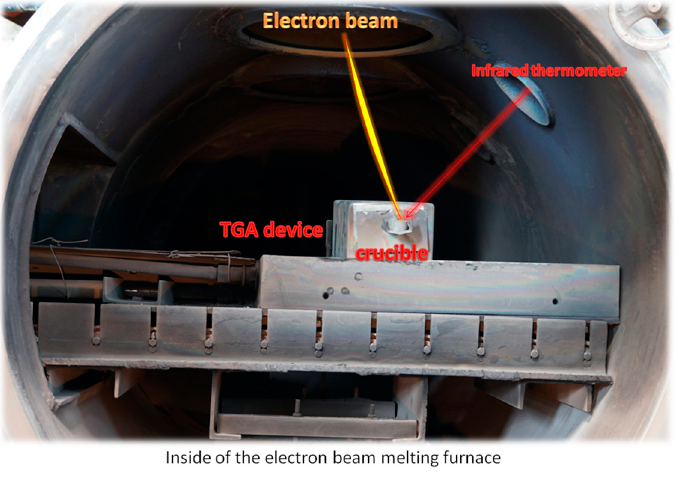
Figure 1. The actual setup and orientation of the TGA.